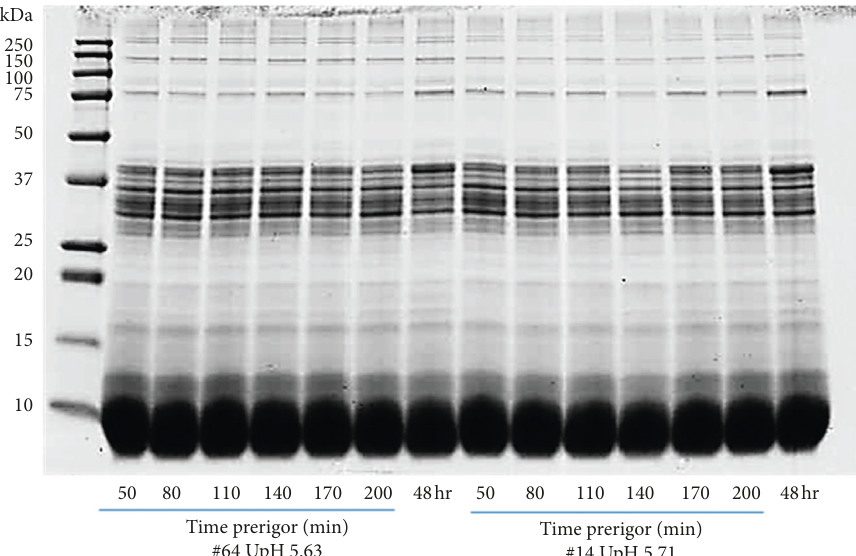
Figure 4: Experiment 2: SDS PAGE showing the effect of pre- and postrigor sampling time on the digestibility of protein in cooked M. longissimus dorsi from bull beef. Results at T60 of gastric phase for two of the 48 animals in this experiment are presented as examples.